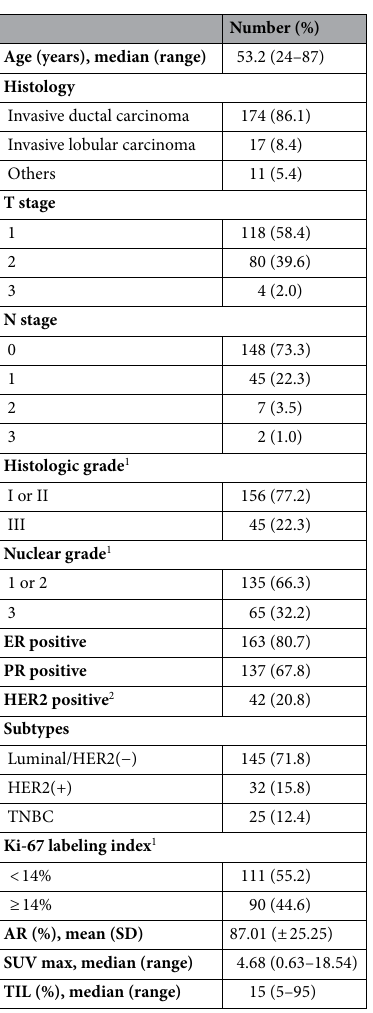
Table 1. Patient characteristics. ER estrogen receptor, PR progesterone receptor, HER2 human epidermal growth factor receptor-2, TNBC triple-negative breast cancer, AR androgen receptor, SUV standard uptake value, TIL tumor-infiltrating lymphocytes. 1 Missing value. 2 HER2 positivity was defined as 3 + on immunohistochemistry or amplification on fluorescence in situ